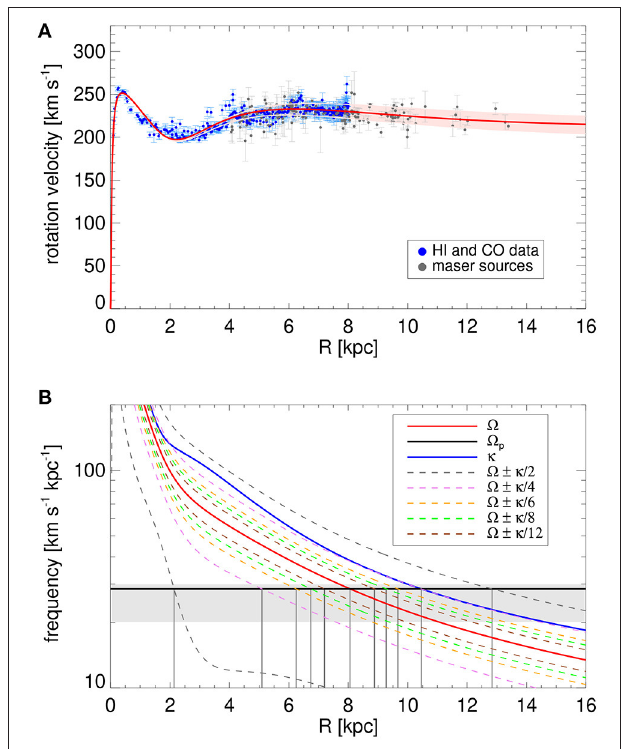
FIGURE 1 | (A) MW’s observed rotation curve: H I and CO tangential directions data are shown as blue dots; maser sources associated with high-mass star-forming regions are shown as gray dots (the references for the observational data are given in section2.1). The red curve is the rotation curve given by the function in Equation (2); the violet curves and the violet shaded region show the confidence intervals of the rotation curve (part of it is hidden behind the H I and CO data points). (B) Galactic frequencies as a function of radius: the angular (cid:127) , epicyclic κ , and the (cid:127) p frequencies are shown as solid curves; the dashed curves represent the linear combinations between (cid:127) and κ . The locations of the LRs are indicated by the gray vertical lines, where the intersections between the dashed curves and the (cid:127) p –curve occur. The 2/1, 4/1, 6/1, 8/1, and 12/1 ILRs and OLRs occur, respectively, at radii smaller and greater than the corotation radius, located at R CR = 8.06kpc in the model. The gray shaded rectangle pictures the range of (cid:127) p –values found in the